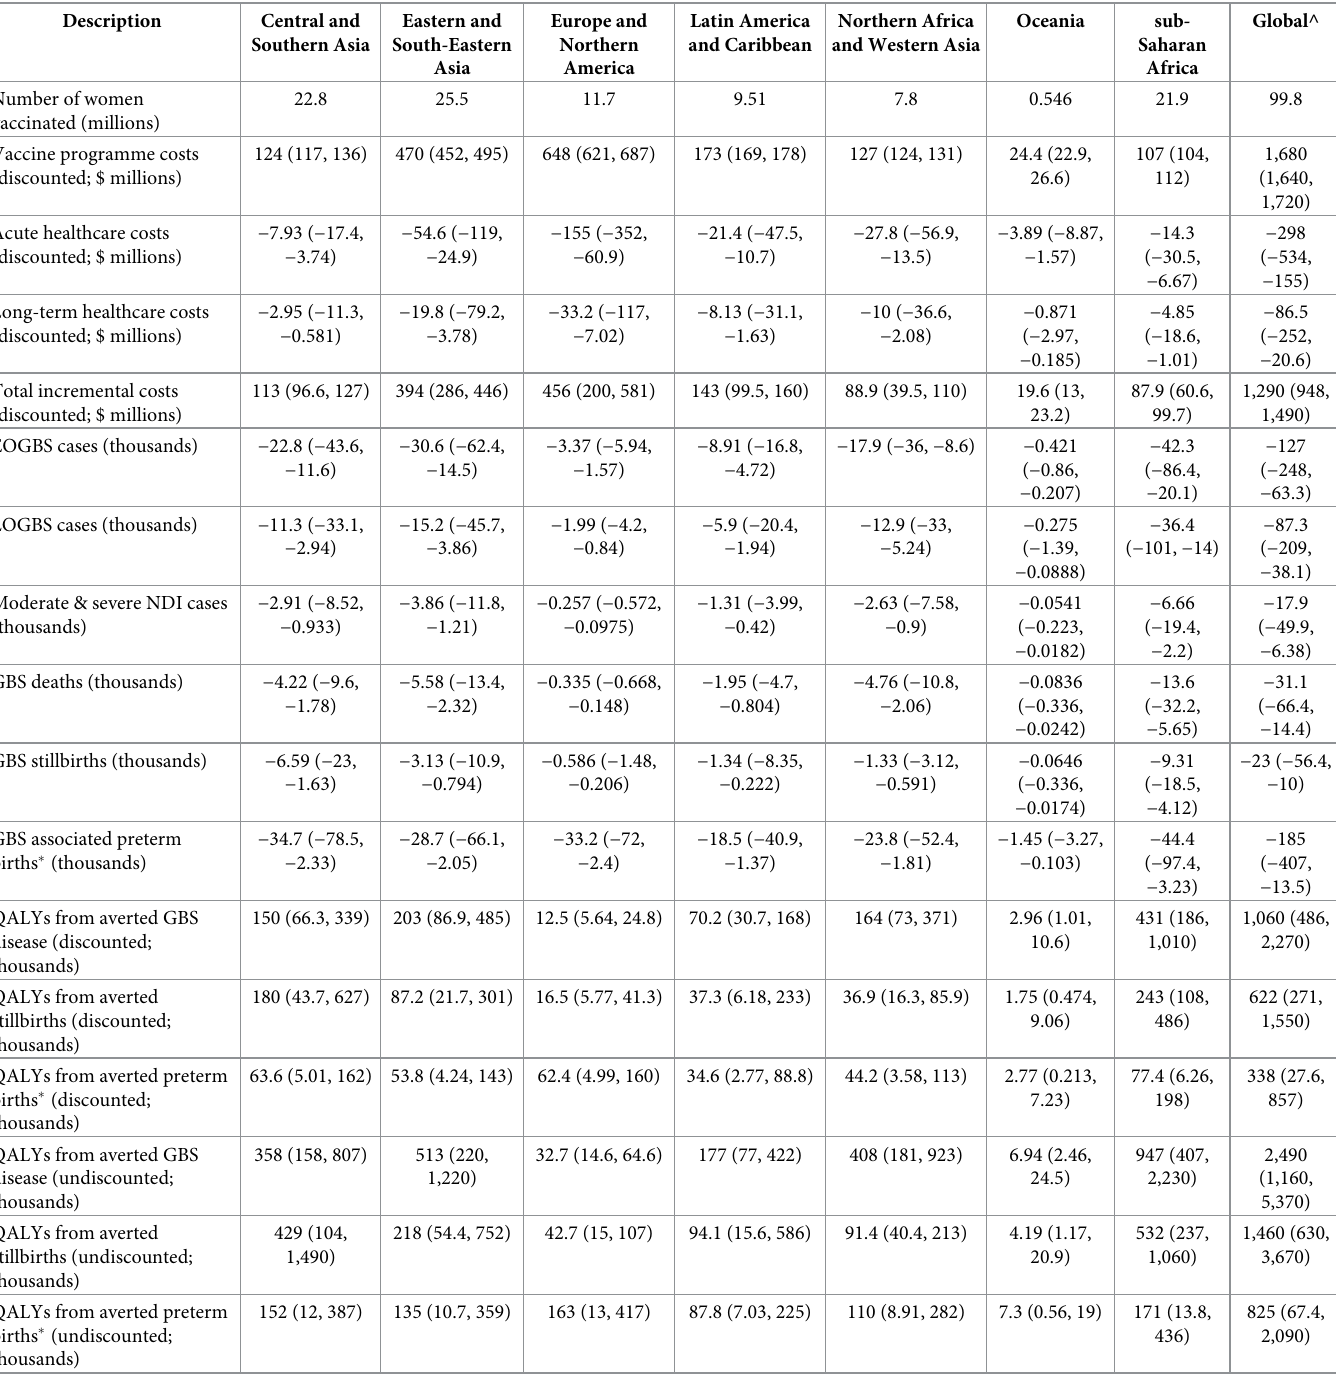
Table 2. Annual global and regional impact of GBS maternal vaccination compared with no vaccination for the year